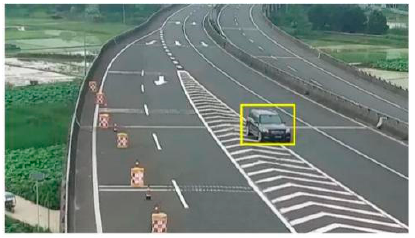
Figure 3. Vehicle Recognition Based on YOLOv4 Target.